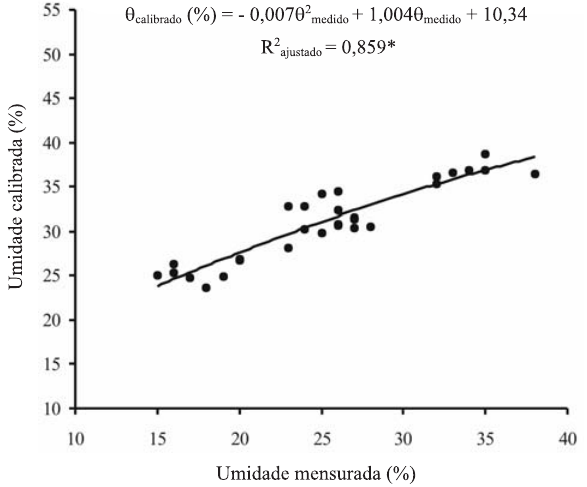
Figura 2. Modelo polinomial de 2° grau ajustado para calibração da sonda TDR aos solos da bacia hidrográfica do ribeirão